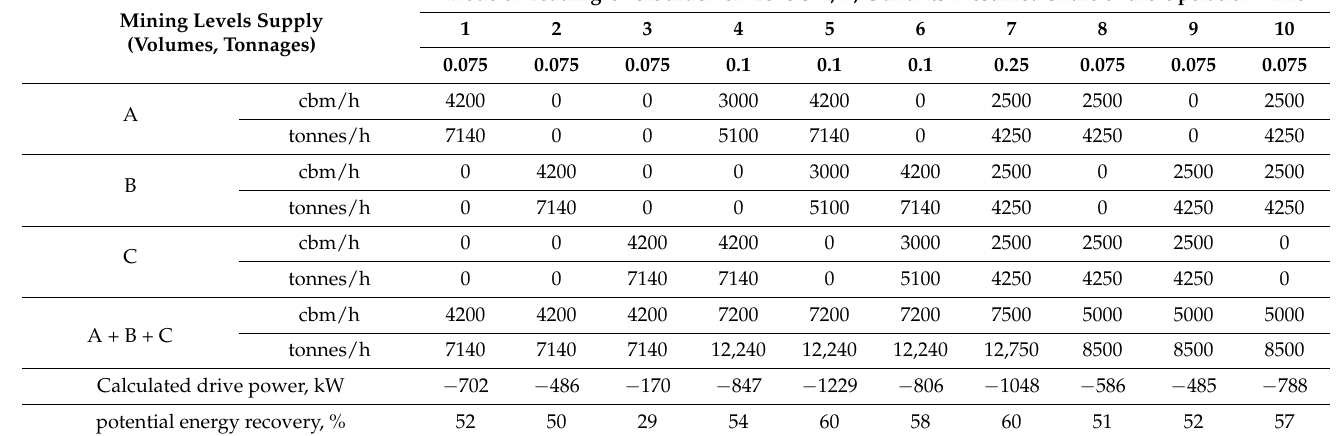
Table 1. Variants of loading the analyzed conveyor on a ramp with overburden stream from three excavators A, B, C at subsequent mining levels (the conveyor is discharged at its head) and the resulting drive power. Mining Levels Supply (Volumes,